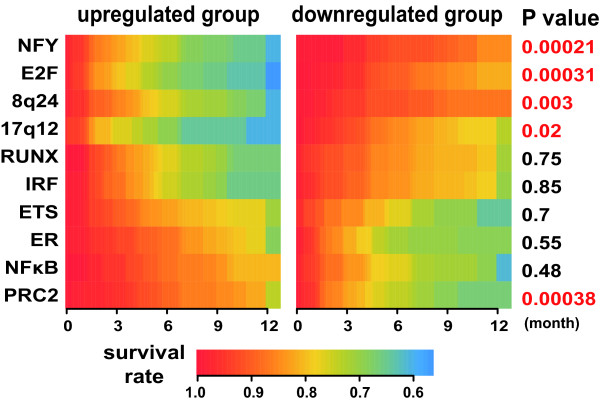
Survival time analysis of expression module activity profiles in breast tumors. Associations between survival time of patients and expression module activities were evaluated. Kaplan-Meier curves for two patient groups with different activities of each expression module were displayed using a color code (high survival rate: red, low survival rate: blue). P values are calculated for coefficients in Cox regression analysis.